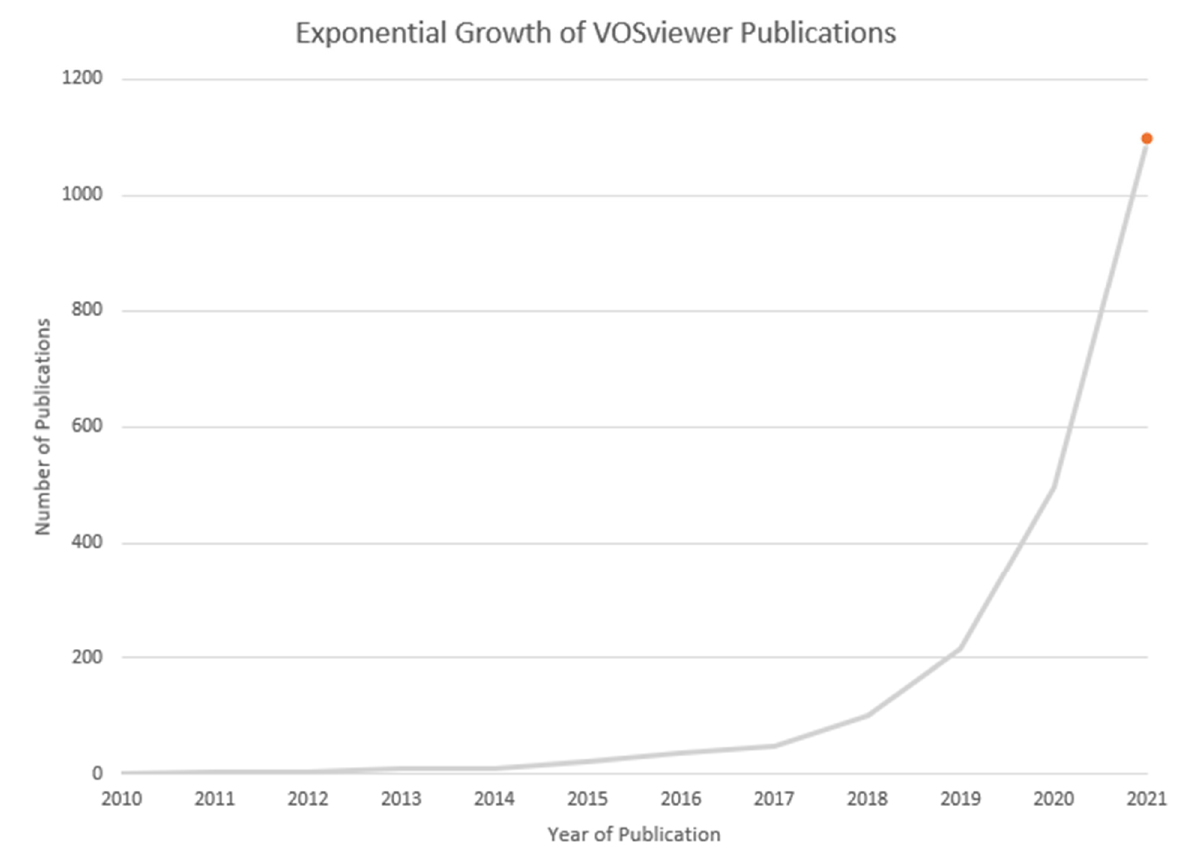
Figure 1. Published papers identifying VOSviewer in the Abstract, title or keywords; source Scopus, data compiled March 2022: see Appendix A.2 for details.